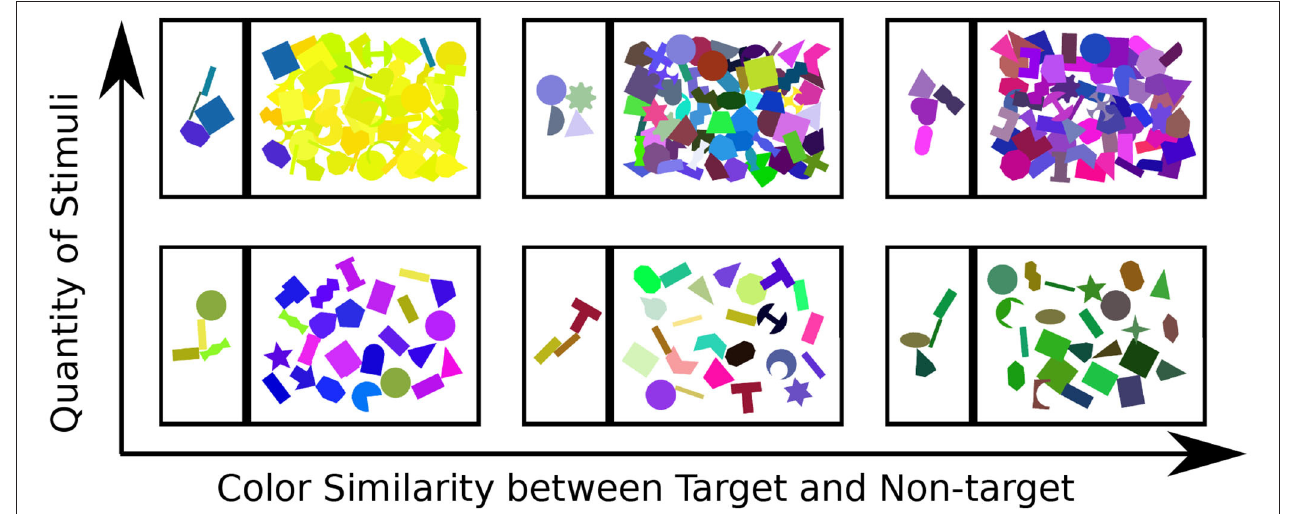
FIGURE 3 | Examples for each of the six types of stimulus scene presented to the participant: top to bottom show the variation in quantity of objects, left-right illustrates the color similarity between target and non-target objects.